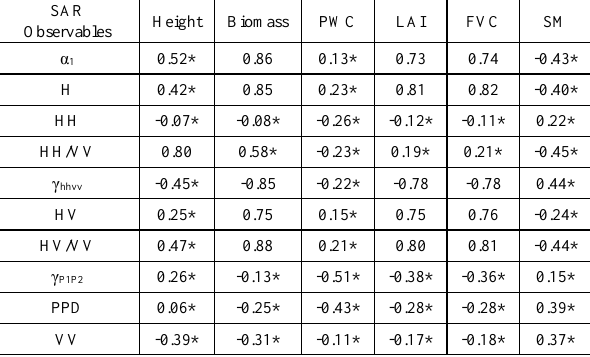
Table 5. Correlation (R Pearson) between SAR observables and field estimations for F11 (barley). Non-significant correlations at 95% confidence level are indicated by *.